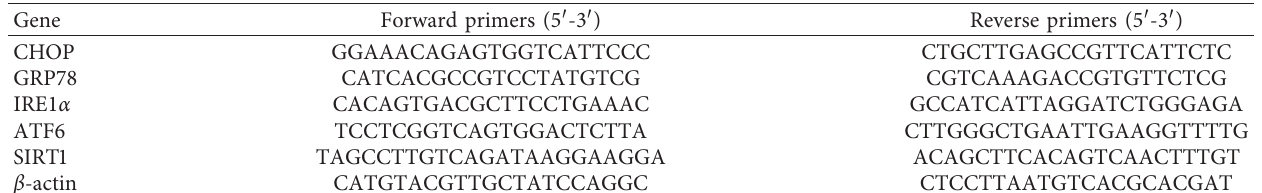
Table 1: The primer sequences.